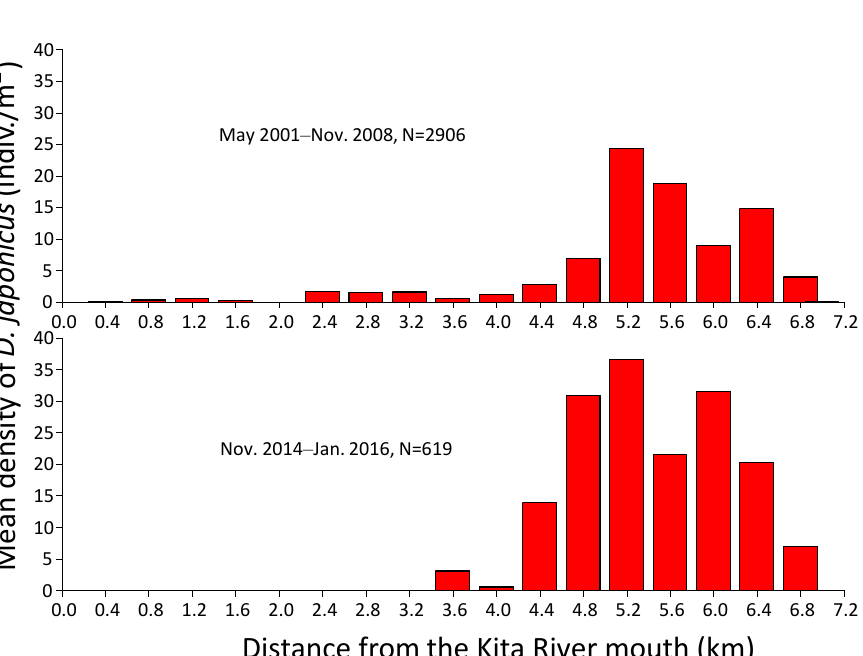
Figure 4. Mean density of all individuals by distance from the Kita River mouth.